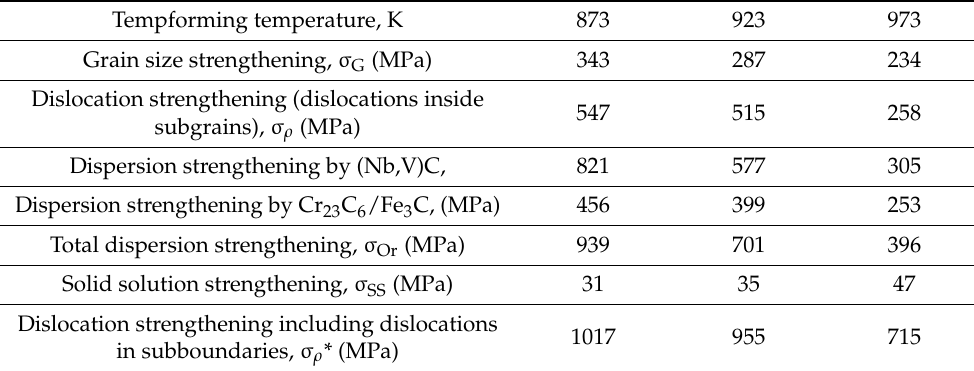
Table 3. Contribution of different strengthening mechanisms to overall yield strength of the steel processed by tempforming at different temperatures. Tempforming temperature, K